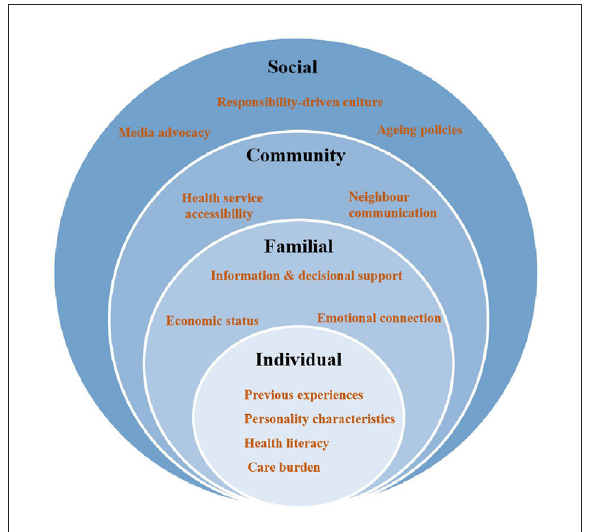
FIGURE1 Socio-ecological framework showing the influences on risk perceptions and responses of informal